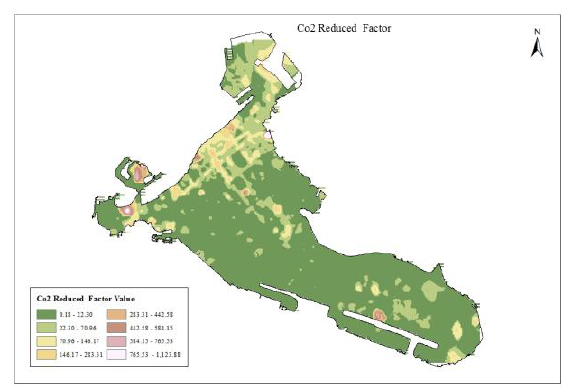
Figure 4 Rasterized CO2 Reduced